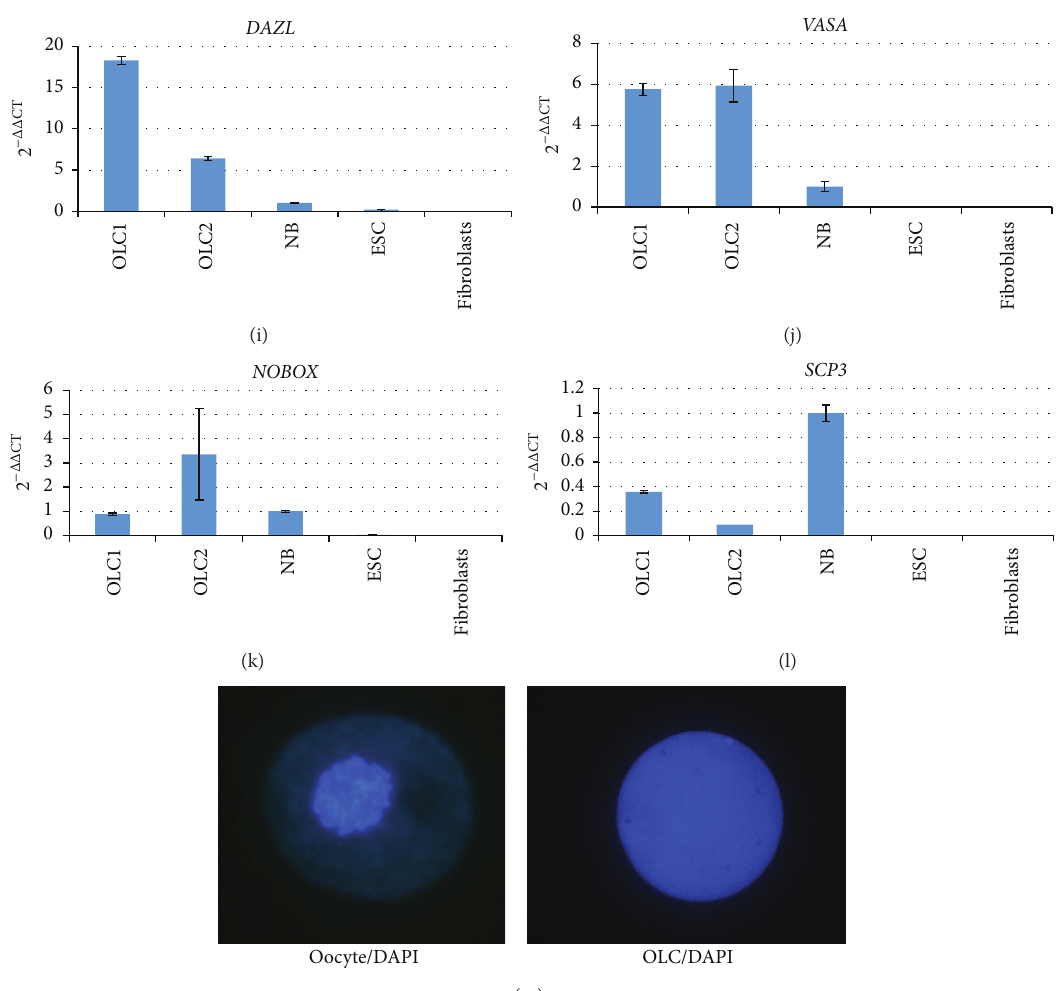
Figure 5: Oocyte-like cells derived from OCCs highly express germ cell markers. (a) Oocyte-like cells that spontaneously developed even in high cell culture passages. The cells were freely floating in the cell culture medium and had a diameter of approximately 40 𝜇 m. The passage numberisindicatedintheupperrightcornerofeachpicture.SometimessmallsphericalstructuresattachedtotheOLCscouldbeseenslightly resembling polar bodies (arrow). (b) Left: a group of natural marmoset monkey oocytes. Some oocytes are still associated with granulosa cells. Right: higher magnification of a marmoset monkey oocyte with a robust Zona pellucida . (c–l) Oocyte-like cells express pluripotency and germ cell markers. Relative mRNA levels of selected pluripotency and germ cell markers in oocyte-like cells as revealed by real-time quantitative RT-PCR. For OCT4A , SALL4 , and LIN28 , ES cells were used as positive control. Neonatal ovary was used as positive control for the germ cell markers. Fibroblasts served as biological negative control. (m) DAPI staining of a natural oocyte (left) and of an OLC. While the oocyte shows strongly compacted chromatin, the DAPI staining of the OLC is homogenous indicating a different chromatin state in OLCs and natural